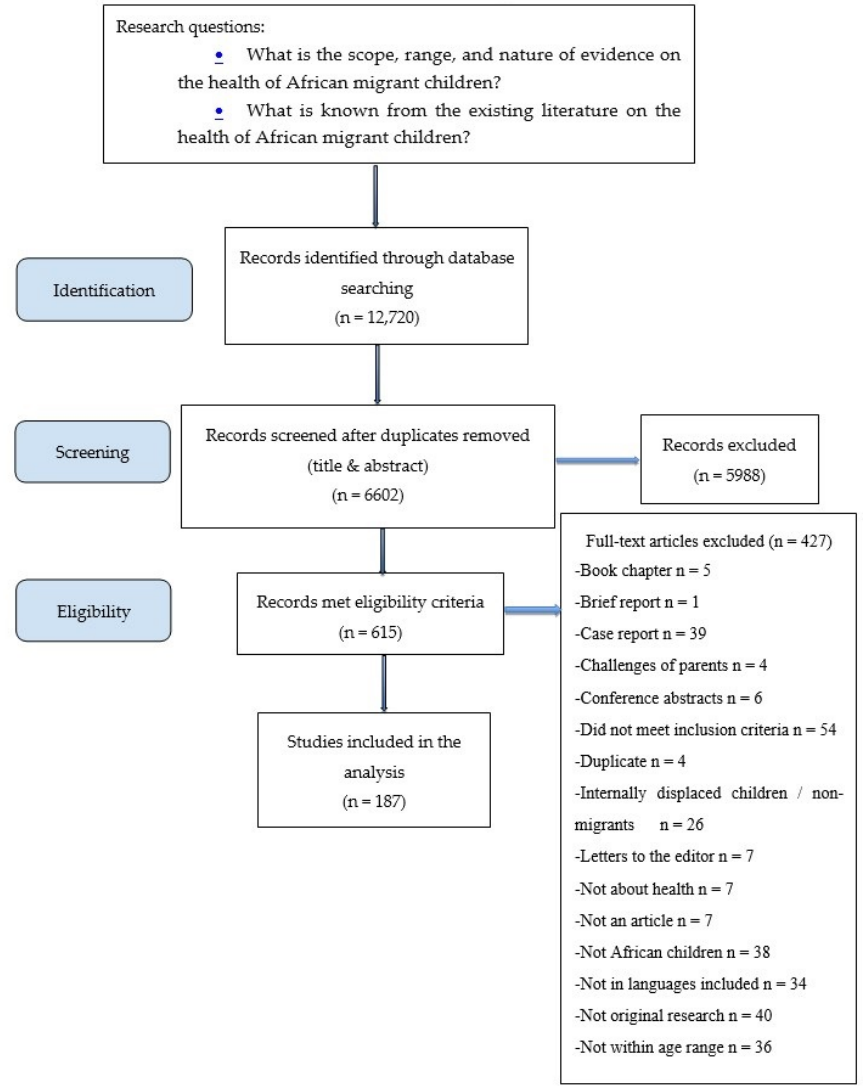
Figure 1. Flow Chart.